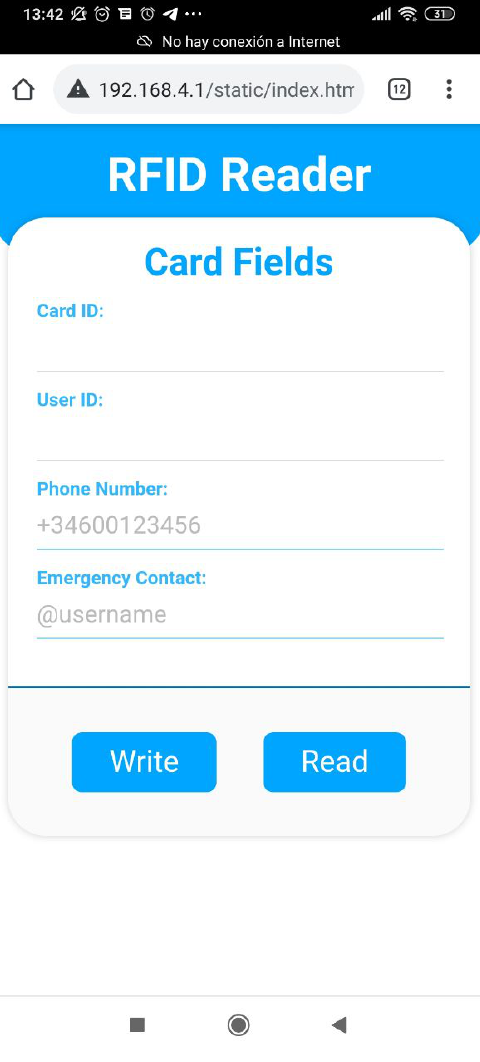
Figure 8. The interface for the RFID writer